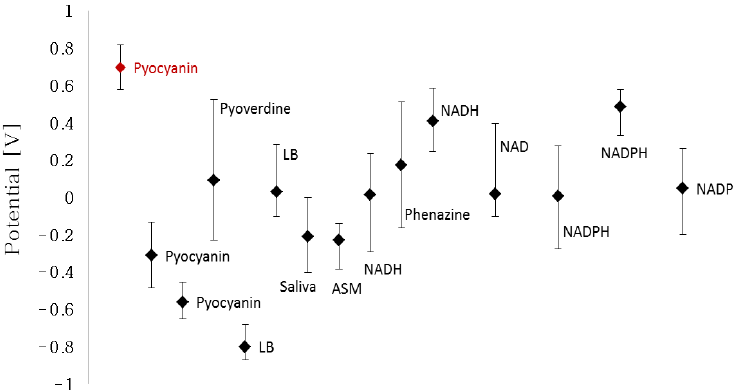
Figure 2. Potential peak values of the different compounds and related detection width (bars) extracted from cyclic voltammograms of the individual compounds. The detection window of pyocyanin with peak at 0.699 V and corresponding start and end potentials lies outside the interaction width of the other redox-active compounds.